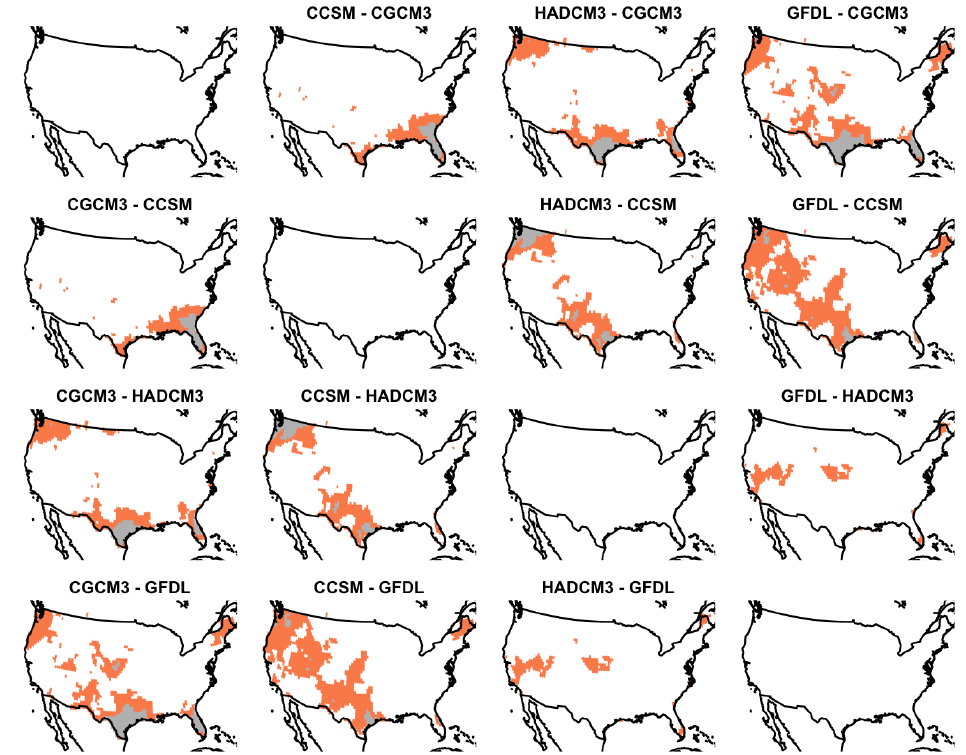
Figure A4. A comparison of the nonzero-effect regions of the average pairwise difference in rate of temperature change for GCM effects of the ASL model using both pointwise and CoPE methods. The grey coloring indicates significant locations at the 0.10 level for both methods, while the orange coloring indicates that the effect is significant for pointwise inference alone.